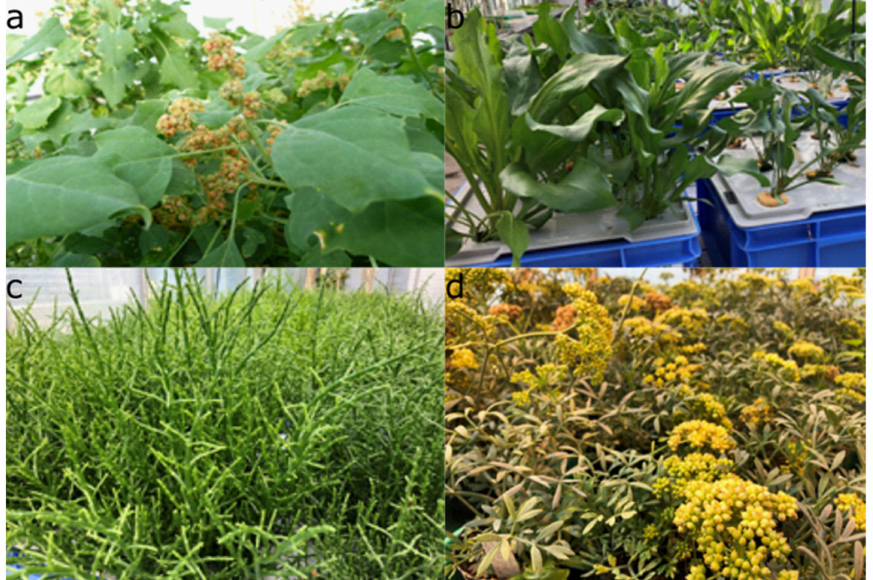
Figure 1. Halophyte plants grown under controlled conditions in hydroponic cultures, ( a ) Chenopodium quinoa , ( b ) Tripolium pannonicum , ( c ) Salicornia europaea and ( d ) Crithmum mariti- mum . Source: Own pictures, Ariel